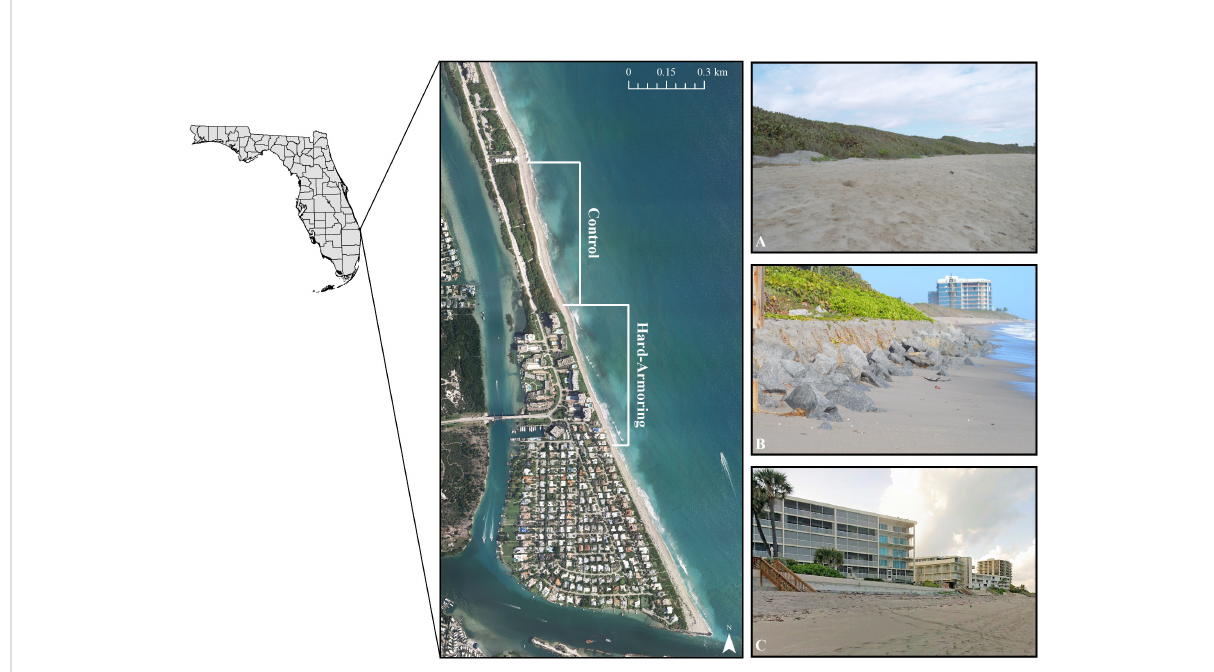
FIGURE 2 Map showing the location of the control and hard-armoring sites on Tequesta and Jupiter Inlet Colony Beaches in northern Palm Beach County, Florida, USA. The control site is characterized by a mostly natural dune system fronting a county park (A) , while the hard-armoring site